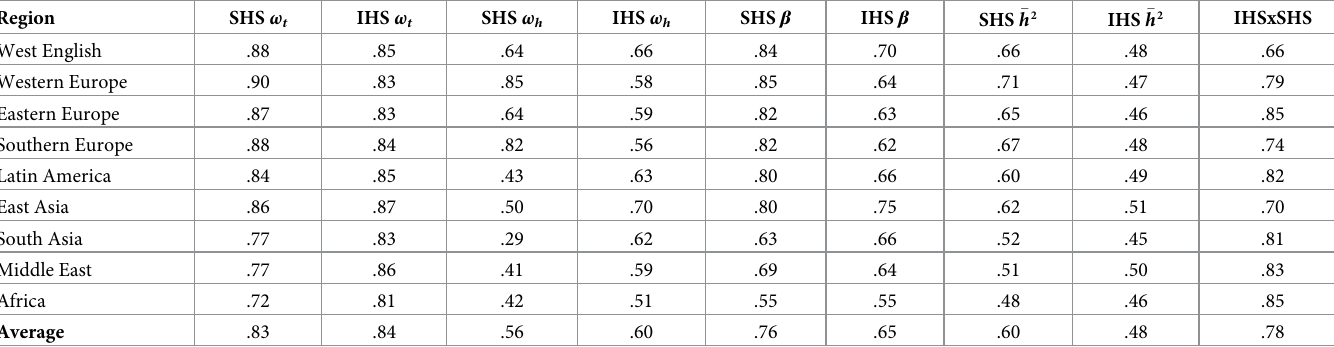
Table 4. Reliability measures for the Subjective Happiness Scale (SHS) and Interdependent Happiness Scale (IHS) averaged by region. Region SHS ω t